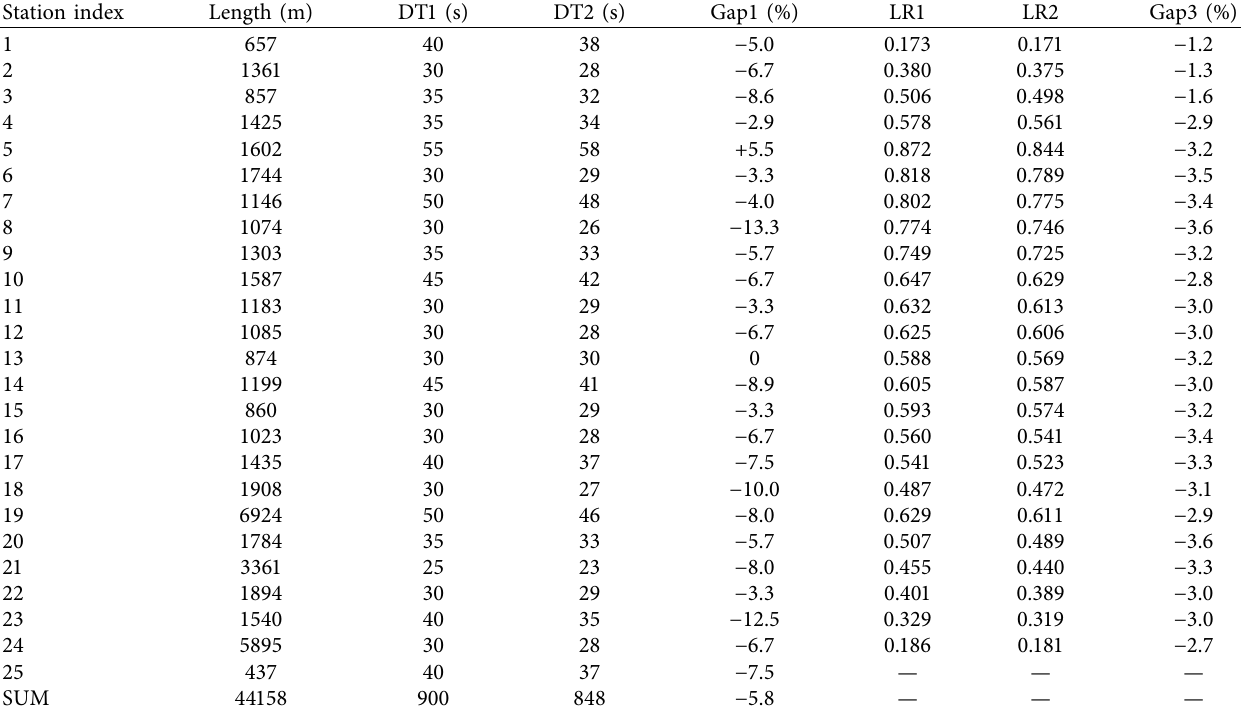
Figure 3: Number of passengers during peak hours. Table 3: Comparison of values under an optimized irregular schedule and the current regular